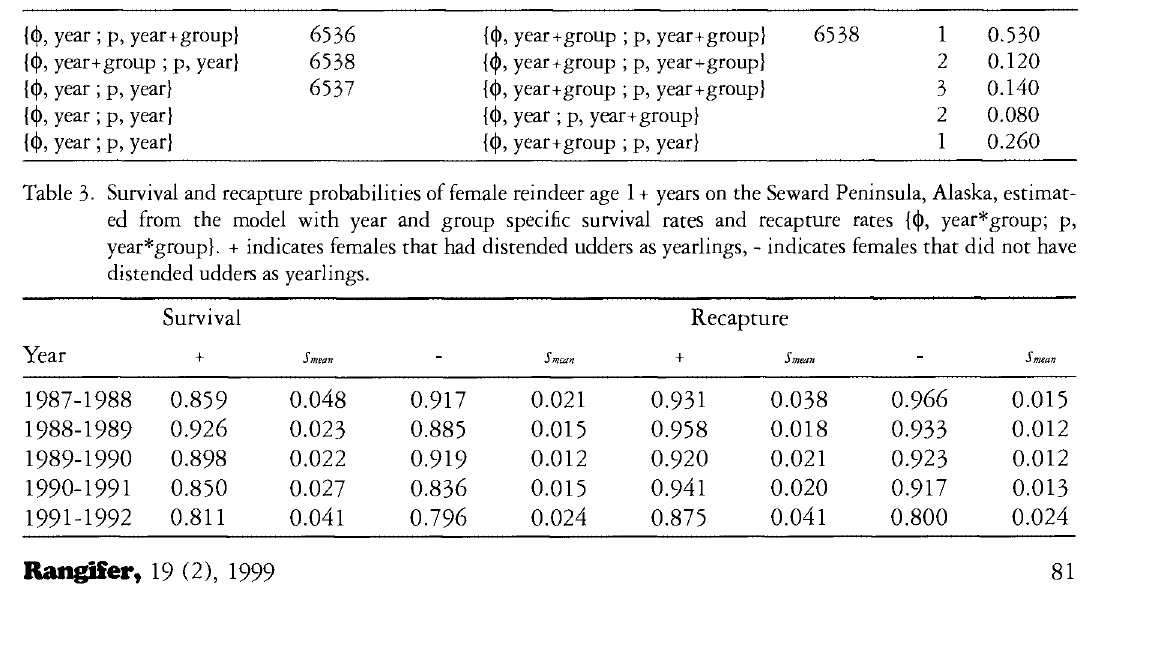
Table 2. Likelihood ratio tests of mark-recapture models of reindeer survival. The model selected contained annual dif ferences in survival and recapture rates but no difference due to group {<)), year ; p, year). Group represents females that had distended udders as yearlings versus those yearlings that did not have distended udders.